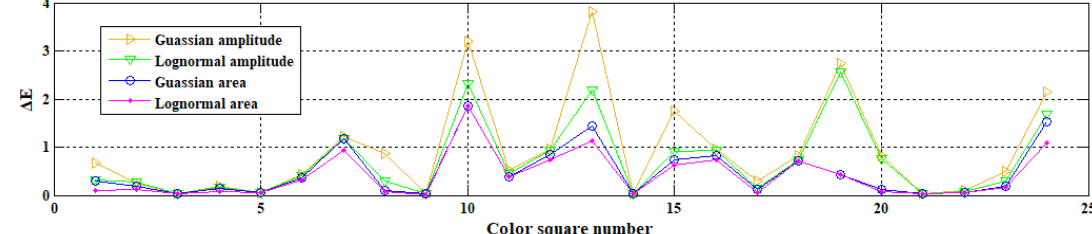
Figure 9. Color restoration results in terms of ∆ E using Gaussian amplitude, lognormal amplitude,